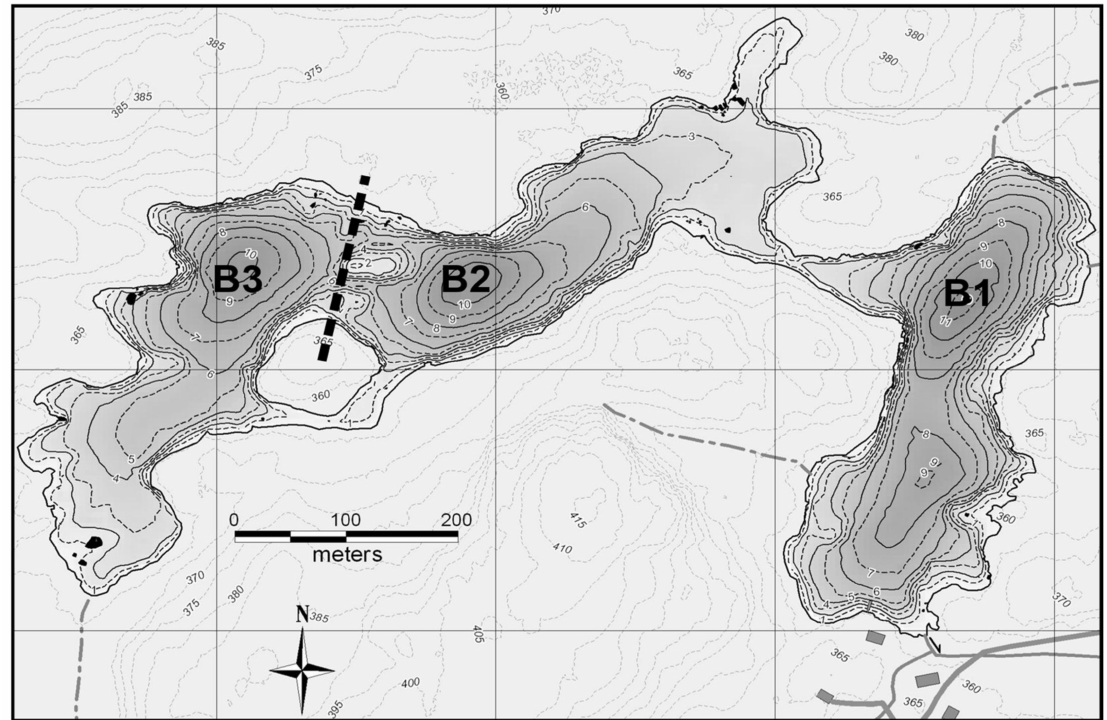
Figure 2. Bathymetric map of the lake (Courtesy of R. Carignan, Station de Biologie des Laurentians, University of Montreal, Montr é al, Quebec). The dotted line represents the curtain and each basin is defined as follows: B1 = control, B2 = passively deepened, B3 = actively deepened. Adapted from Ouellet Jobin and Beisner